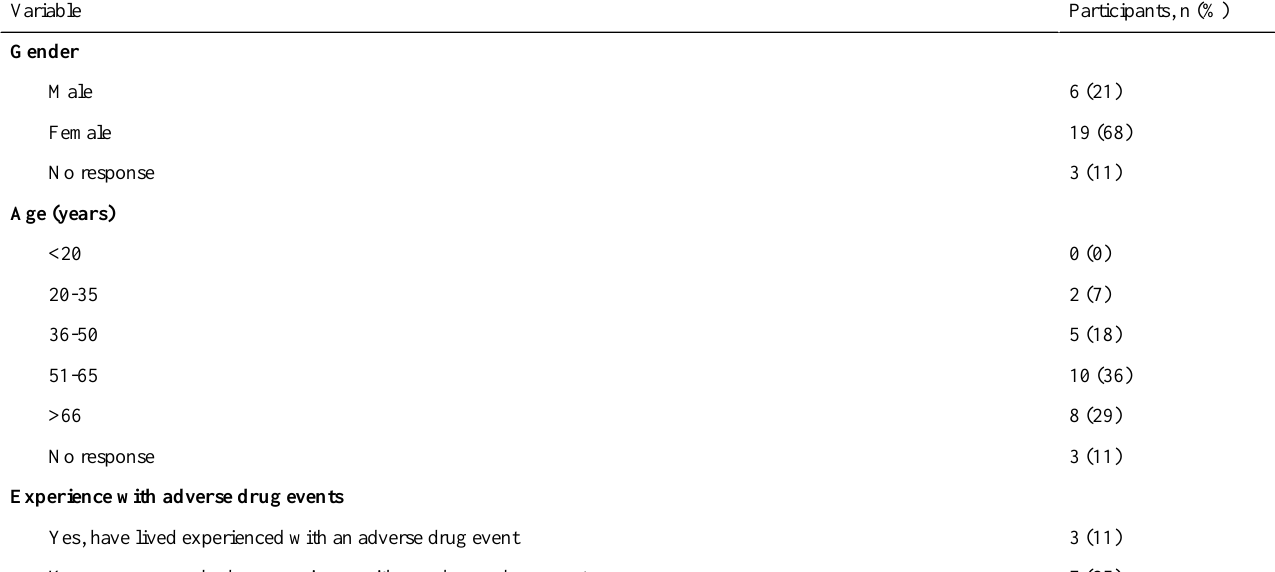
Table 2. Participants’characteristics